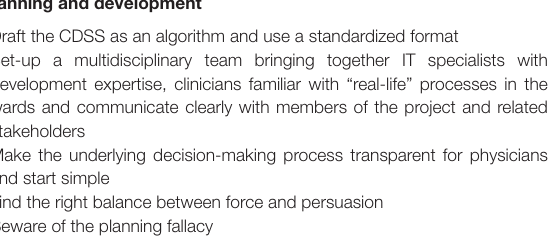
TABLE 1 | Key messages when designing and implementing your CDSS for antimicrobial prescriptions.